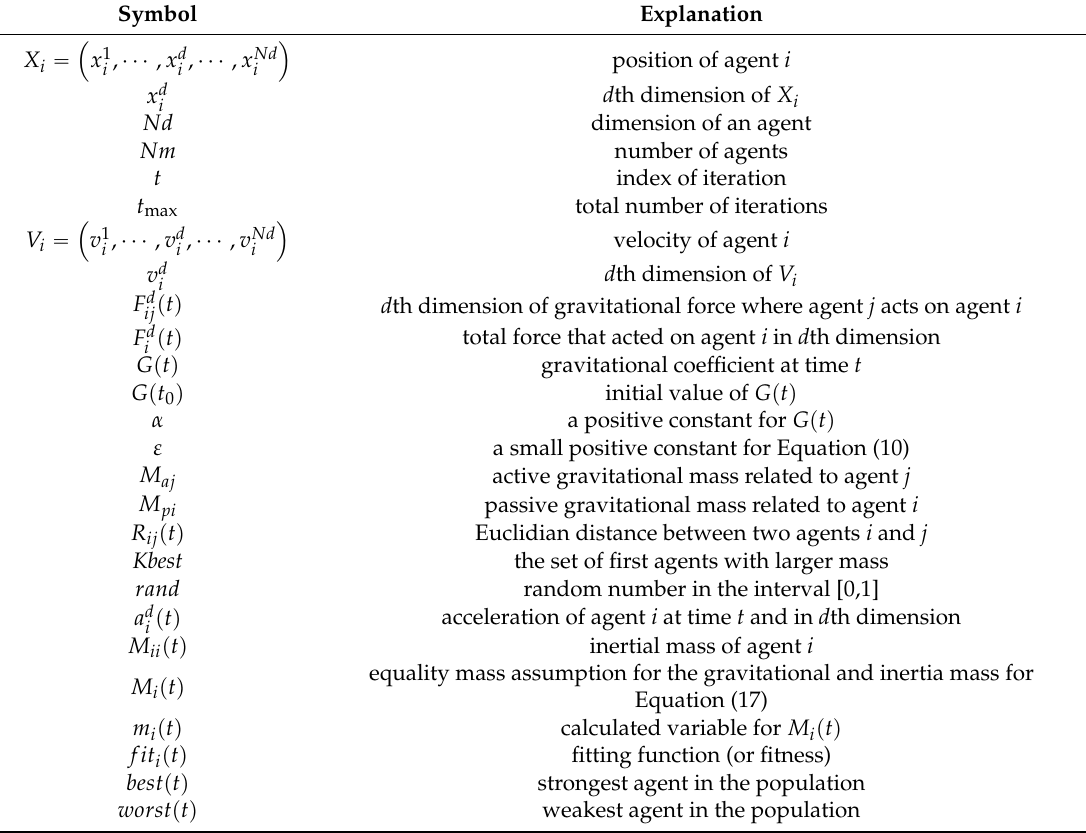
Table 2. Symbol summary for